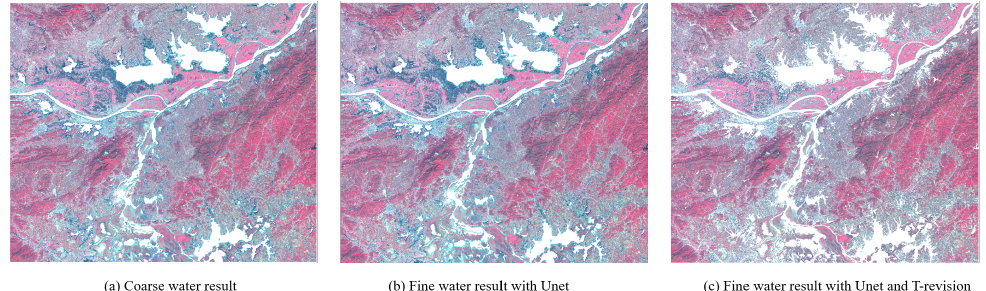
Figure 12. Fine water extraction of GF-1